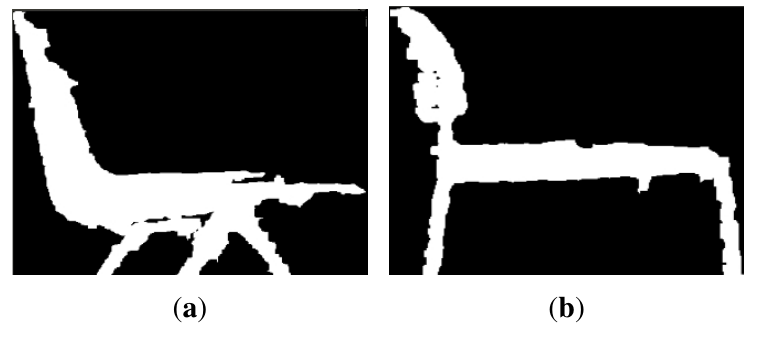
Figure 12. Experiment 1, Chair. ( a ) Experiment 1, Chair 1; and ( b ) Experiment 1, Chair